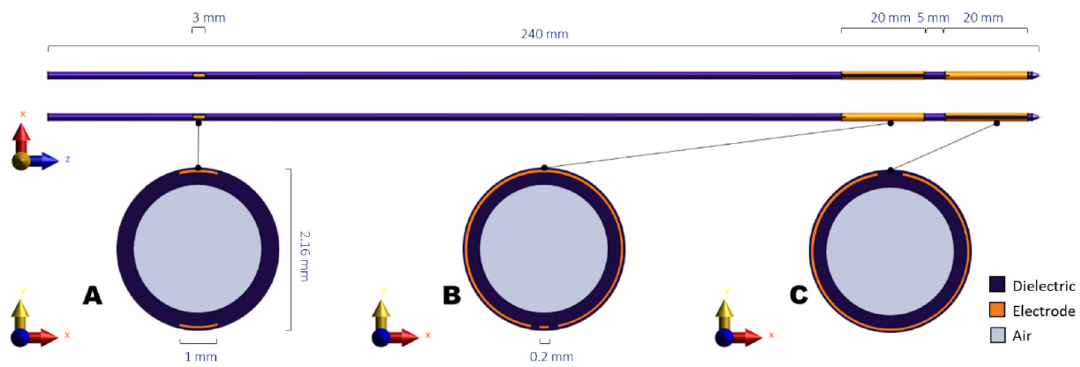
Figure 1. Schematic representation of the ThermoBrachy applicator. ( A – C ) show cross-sections of the applicator at the level of the connector patches, the proximal electrode center, and the distal electrode center,